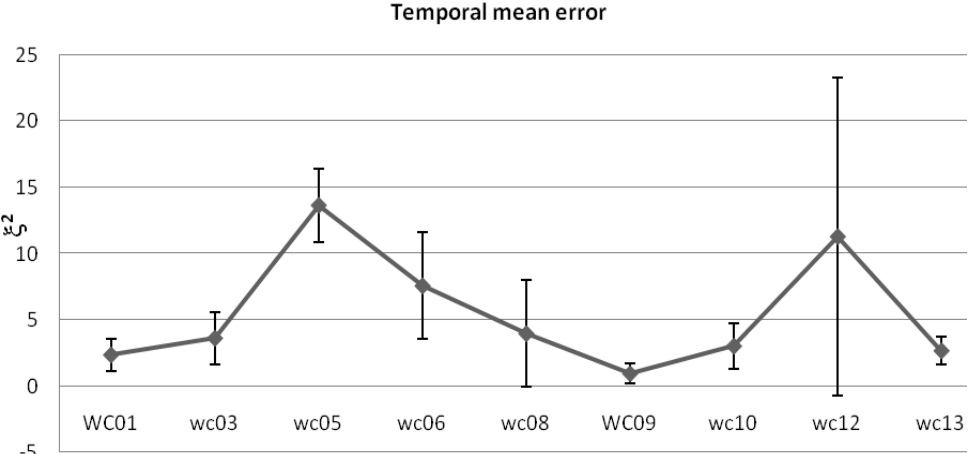
Figure 4 . The error ξ 2 variability for each field is reported. The errors have been averaged over all inversion algorithms and all four dates. The error bars are ±1.0 standard deviation with respect to the mean